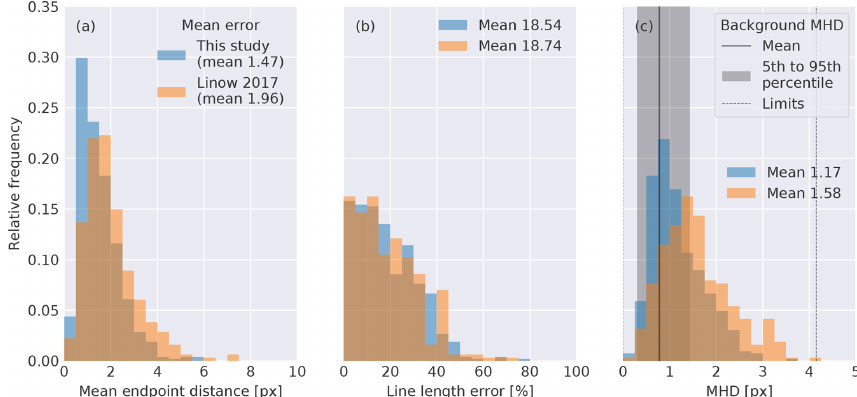
Figure 6. Statistics of all full matching pairs computed for the algorithm presented here and the original version (Linow and Dierking, 2017): (a) the mean endpoint distance, (b) the line length error, and (c) the modified Hausdorff distance (MHD). The background MHD refers to MHD calculated for the handpicked features and the morphological thinned binary field (Fig.